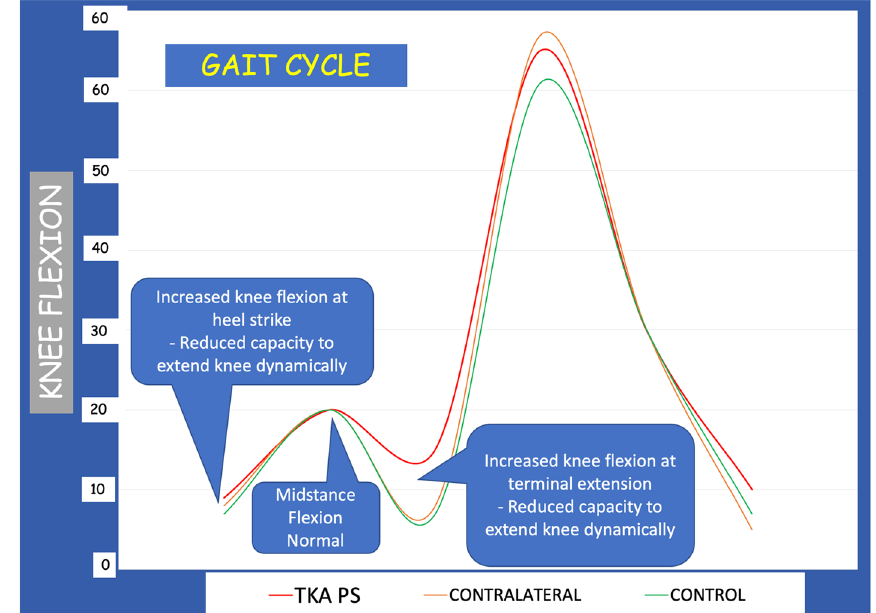
Fig. 1 Analysis of knee flexion during Gait Cycle. A Heel-strike: both groups (PS TKA and healthy controls) showed a slight flexion contracture at heel-strike. The difference between the two groups was not statistically significant. B Mid-stance flexion angle. There was a trend that the average mid-stance knee flexion angle in the bi-cruciate substituting PS TKA group (16.1°) was lower than the healthy controls group (20.7°) ( P